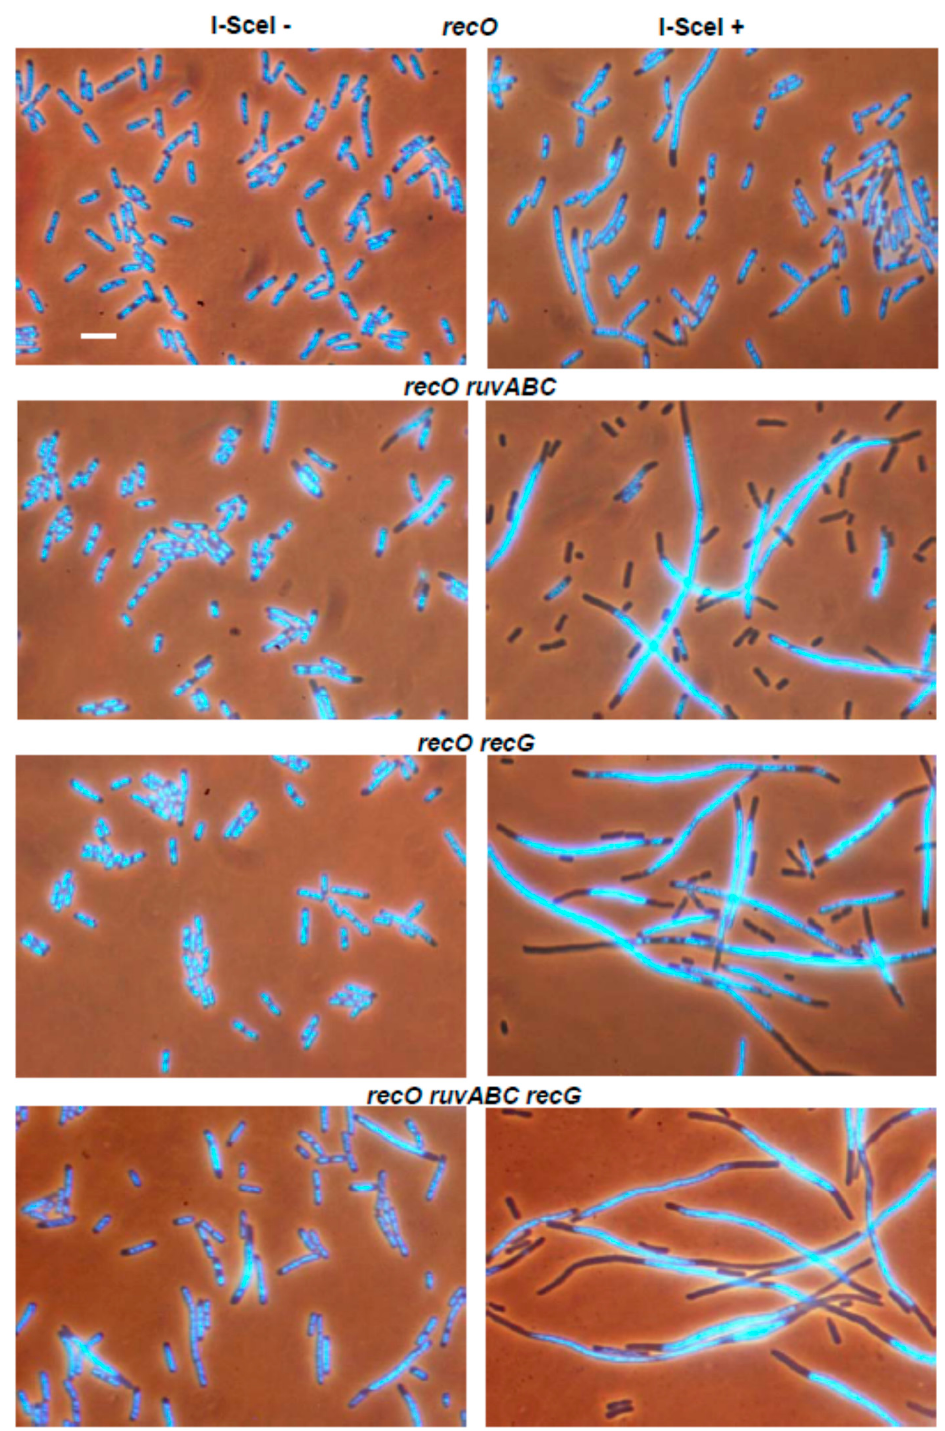
Figure 3. The recO mutation does not influence I- Sce I-induced cytological defects in ruvABC and/or recG mutants. Bar, 5 μ m.